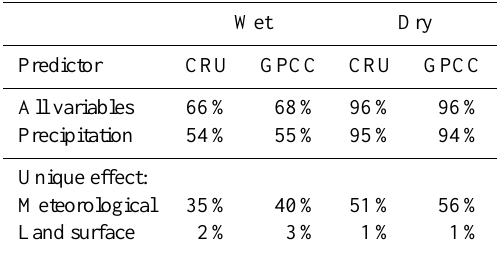
Table 1. The proportion of interannual variability explained by all predictor variables and precipitation only (expressed as R 2 ) , and the unique effect of meteorological and land surface variables as in- ferred from variance partitioning (expressed as adj. R 2 ) across wet and dry basins using CRU- and GPCC-based ET and precipitation, respectively.